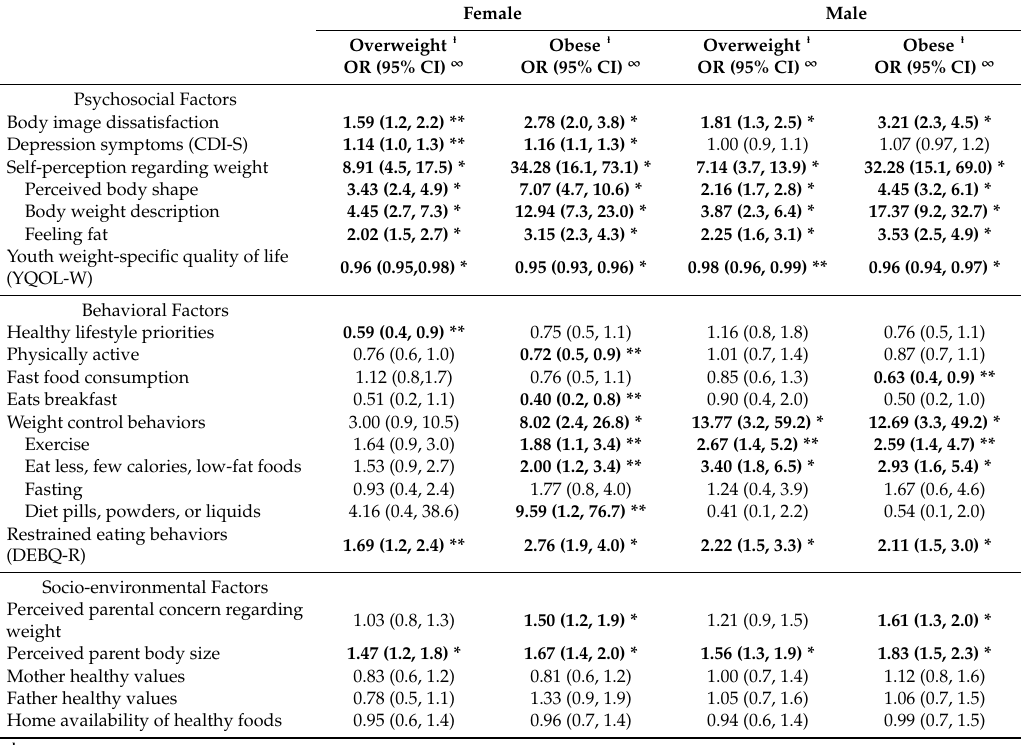
Table 5. Association between psychosocial, behavioral, and socio-environmental factors and overweight or obesity, by sex ( n = 633). Table 2. Comparison of various psychosocial, behavioral, and socio-environmental factors by BMI category among youths in Mexico ( n = 181).